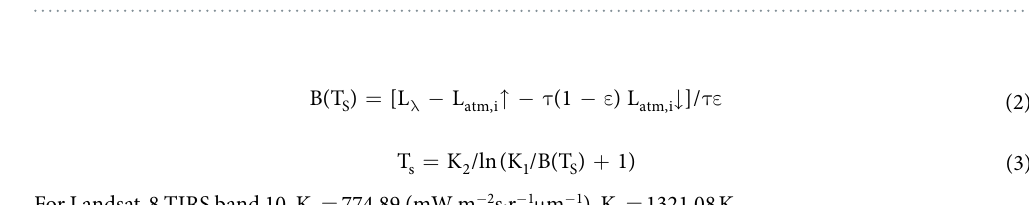
Figure 4. The conceptual curve of urban cooling island (UCI) extent, intensity, efficiency, and TVoE. The q 1 to q 2 equal q 3 to q 4 , u 2 –u 1 greater than u 4 –u 3